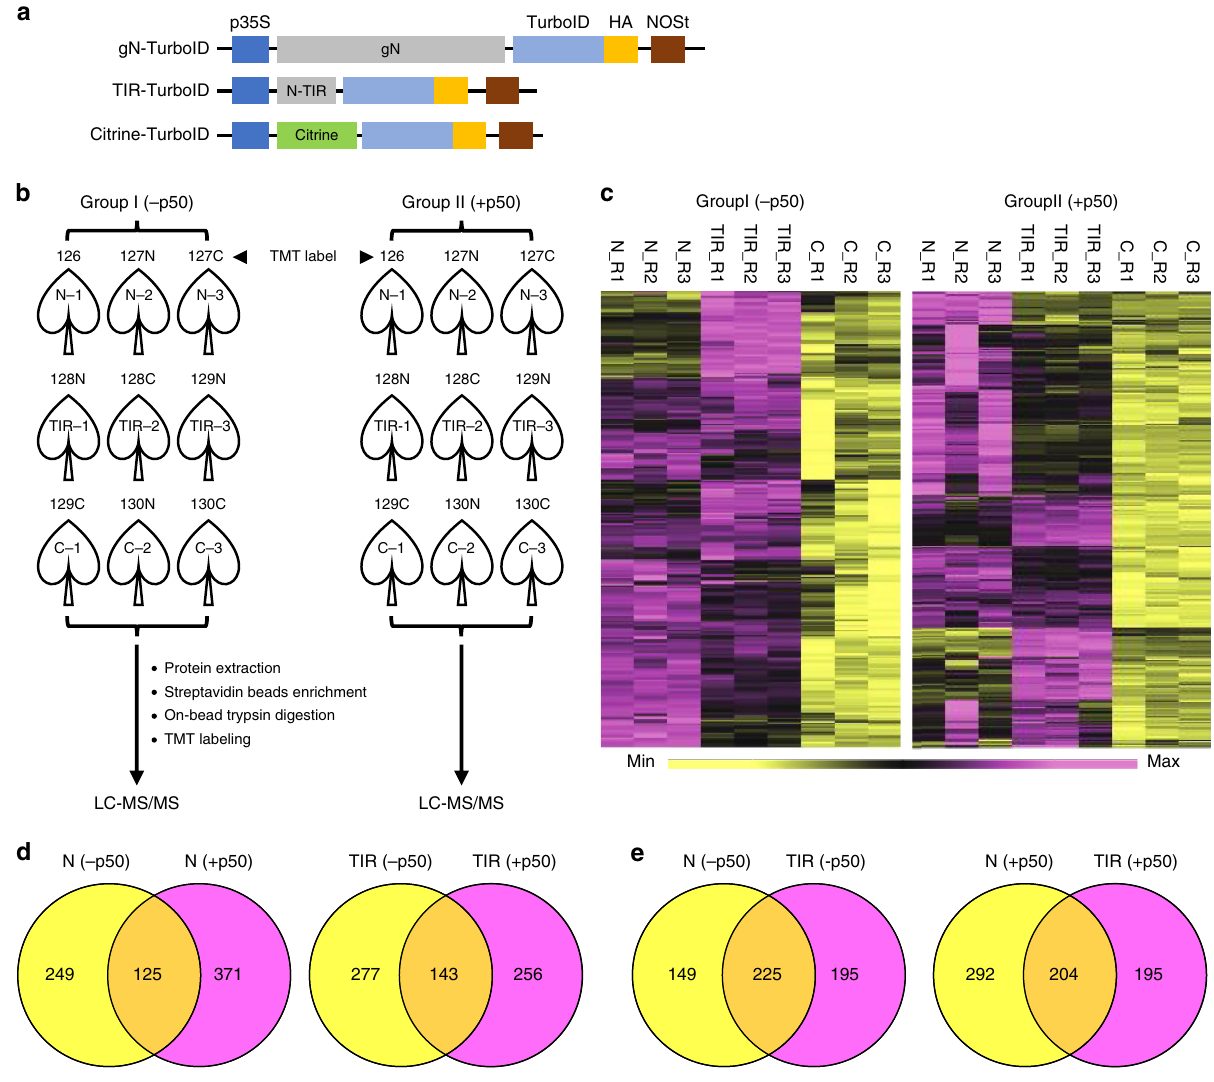
Fig. 2 Identi fi cation of proximal and interacting proteins of N NLR immune receptor. a Schematic representation of the constructs used for the identi fi cation of proximal and interacting proteins of N. b Diagram of the experimental design and labeling conditions. TurboID fusions without p50 (Group I) or with p50 that is under the control of the β -estradiol inducible promoter (Group II) were co-in fi ltrated into N. benthamiana leaves. At 36 hpi, 200 µ M biotin and 30 µ M 17- β -estradiol were in fi ltrated into both groups of pre-in fi ltrated leaves. 12 h later, leaf cells were lysed and biotinylated proteins were enriched with streptavidin beads, digested by trypsin, and labeled with tandem mass tags (TMT). Each treatment consisted of three independent biological replicates. All 9 samples in Group I or Group II, respectively, were then independently combined within group and analyzed by LC-MS/MS. c Hierarchical clustering of the Group I and Group II signi fi cantly enriched interacting proteins. Enriched interactors exhibited a >1.5 fold enrichment over the Citrine control and a q -value less than 0.05. d Venn diagrams depicting the proteins that interact with gN (left) or N-TIR (right) in the absence or presence of p50. e Overlap in the proteins that interact with gN and/or N-TIR in the absence (left) or presence (right) of